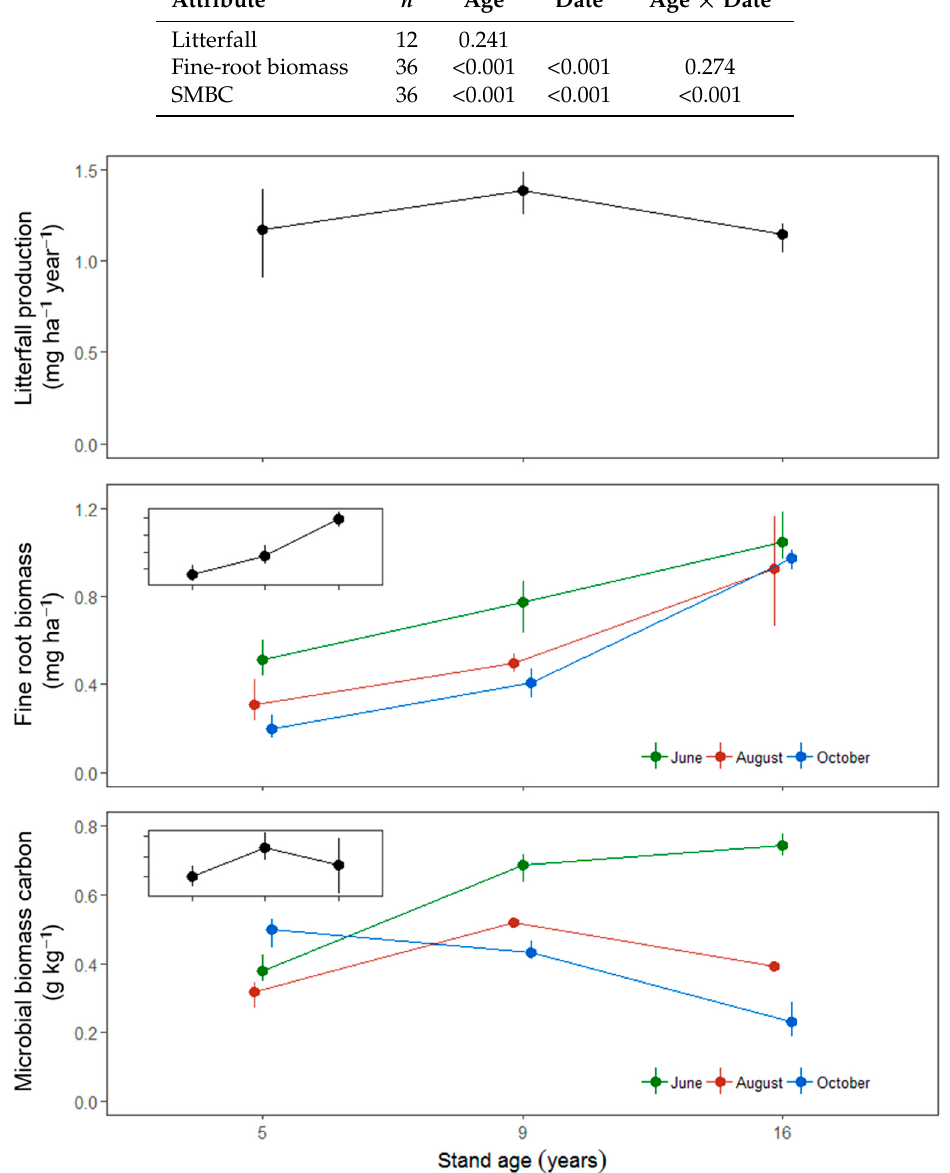
Figure 4. The effect of stand age on annual litterfall production ( n = 4), fine-root biomass, and soil microbial biomass carbon in the topsoil (0–10 cm) of poplar plantations ( n = 3). Inserts are the means for the three sampling dates. Values are bootstrapped means ± 95% confidence intervals (CIs). Differences between stand ages or size classes are significant at α = 0.05 if their CIs do not overlap the other’s mean.